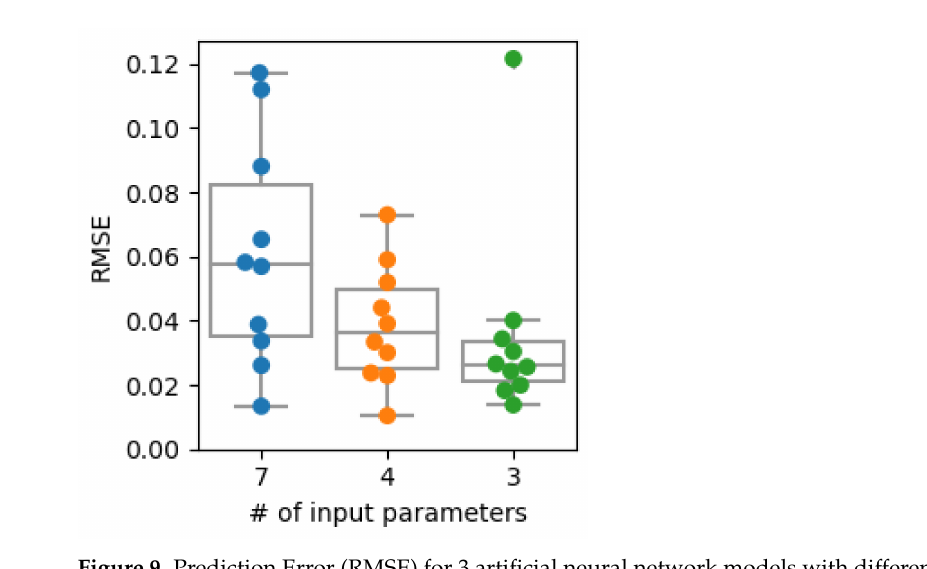
Figure 9. Prediction Error (RMSE) for 3 artificial neural network models with different numbers of input parameters.